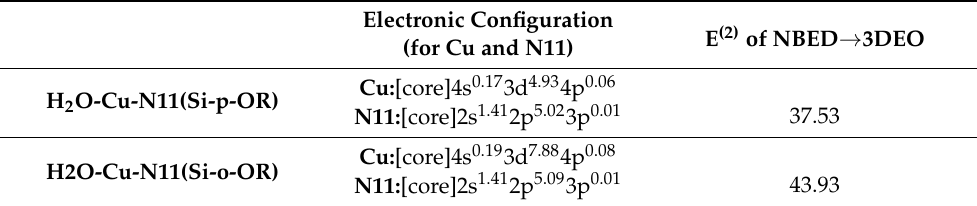
Table 9. E (2) energy calculation (kcal/mol) related to the coordination of NBED of N11 with 3d-empty orbital (3DEO) of